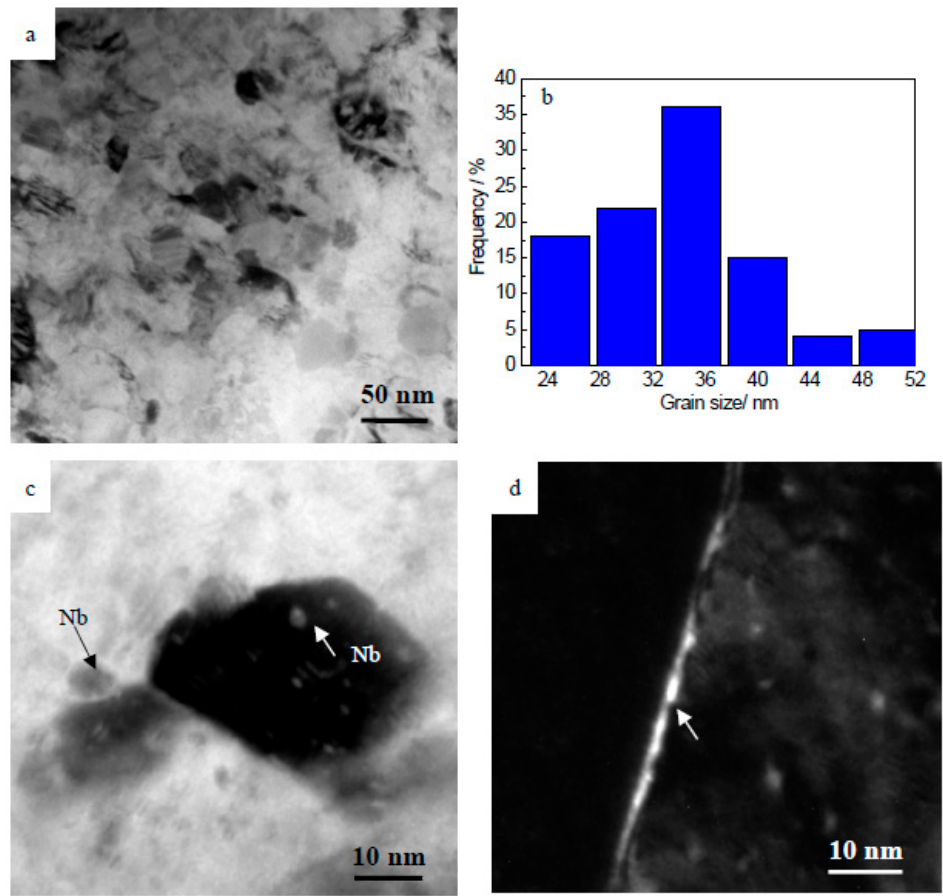
Figure 4. TEM images of MA-ed Cu-Nb powders annealed at 700 ◦ C for 1 h. ( a ) BF image, nanocrystalline Cu grains; ( b ) Cu grain size distribution histogram; ( c ) BF image, Nb nanoparticles; ( d ) DF image, which is formed by selecting one part of the (110) Nb reflection. The segregation at grain boundary is indicated by the arrow. Metals 2016 , 6 , 194